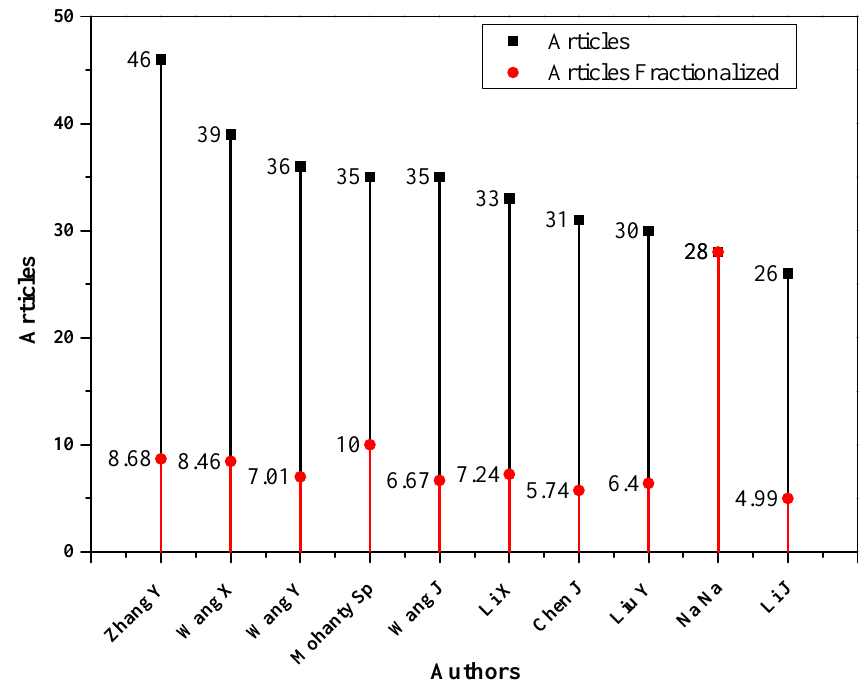
Figure 5. Most relevant and influential authors for IoMT